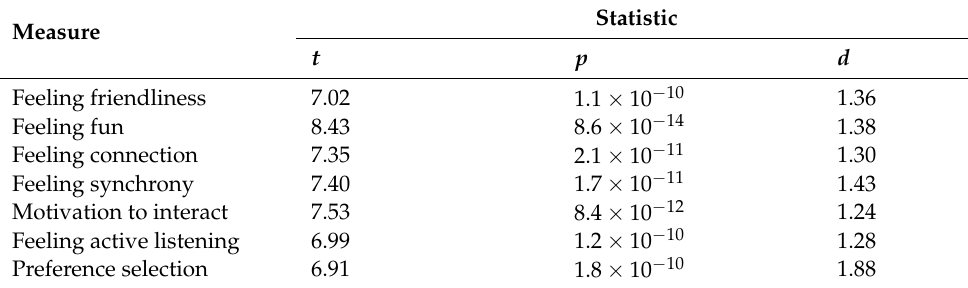
Table 2. Results of one-sample t -tests for the questionnaire responses.